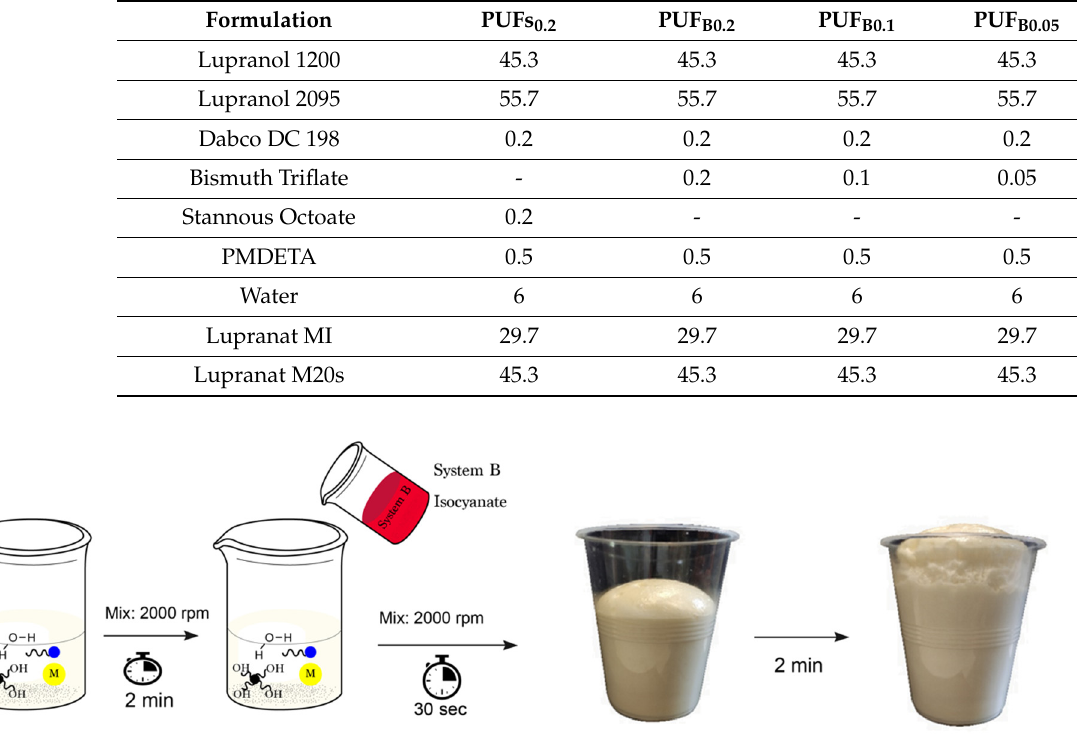
Figure 1. Schematic representation of the free-rise foam production.